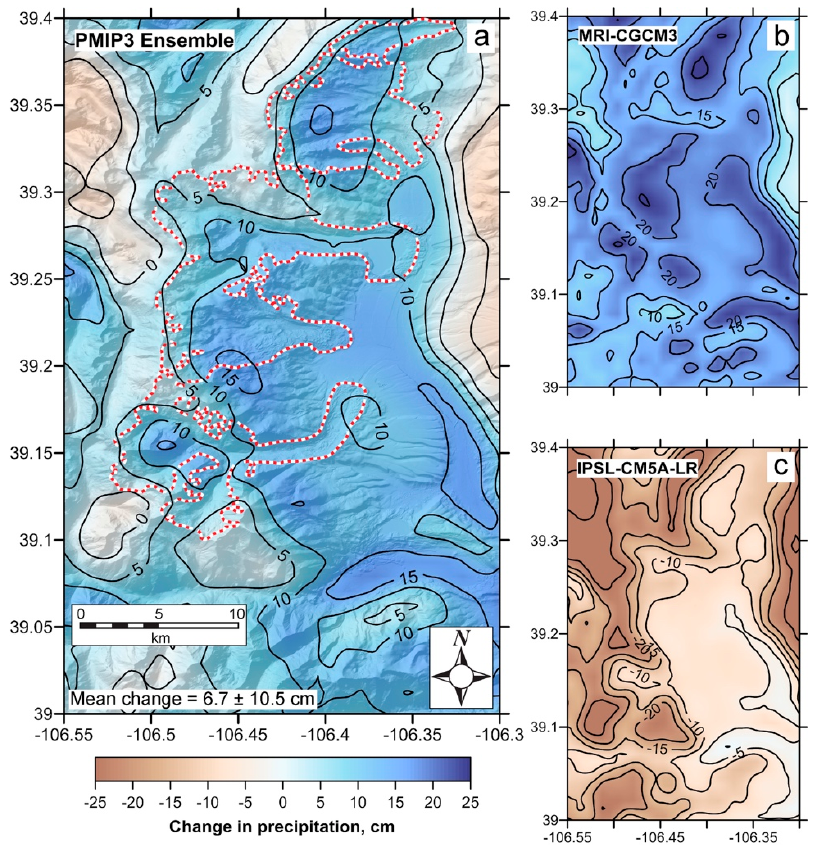
Figure 6. Changes in LGM mean annual precipitation in the study area from ( a ) the CHELSA downscaled PMIP3 ensemble, and ( b ) the “wettest” and ( c ) driest scenarios within the ensemble. Glacier areas (simplified) used for clipping the CHELSA grids are indicated by the red and white lines in ( a ).